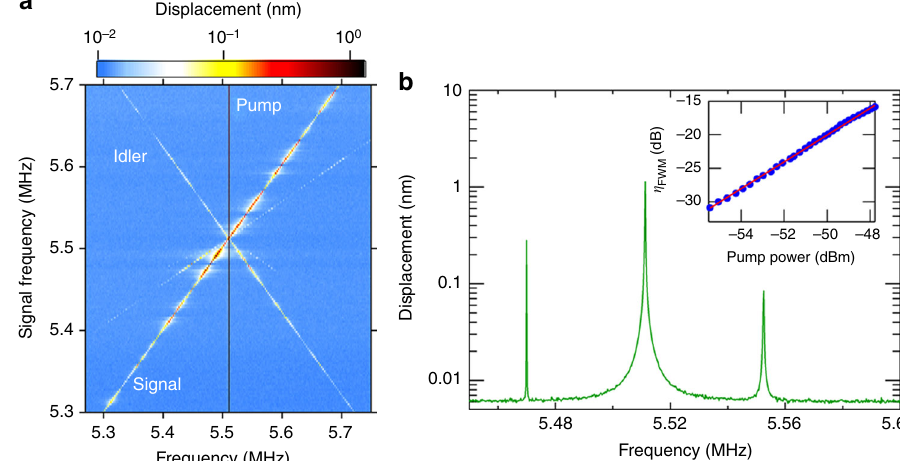
Fig. 5 Ultrasonic four-wave mixing. a The spectral response measured at L = 9 mm when exciting the pump at f p = 5.5112 MHz with 2 V rms and sweeping the signal in f s = 5.3 – 5.7 MHz with 0.5 V rms . b The spectral response with f s = 5.47 MHz where a new idler wave is generated at f i = 5.5524 MHz. The inset shows the conversion ef fi ciency η FWM as a function of the pump input power. The blue circles and red line show the experimental results and theoretical fi tting from Eq. (10),